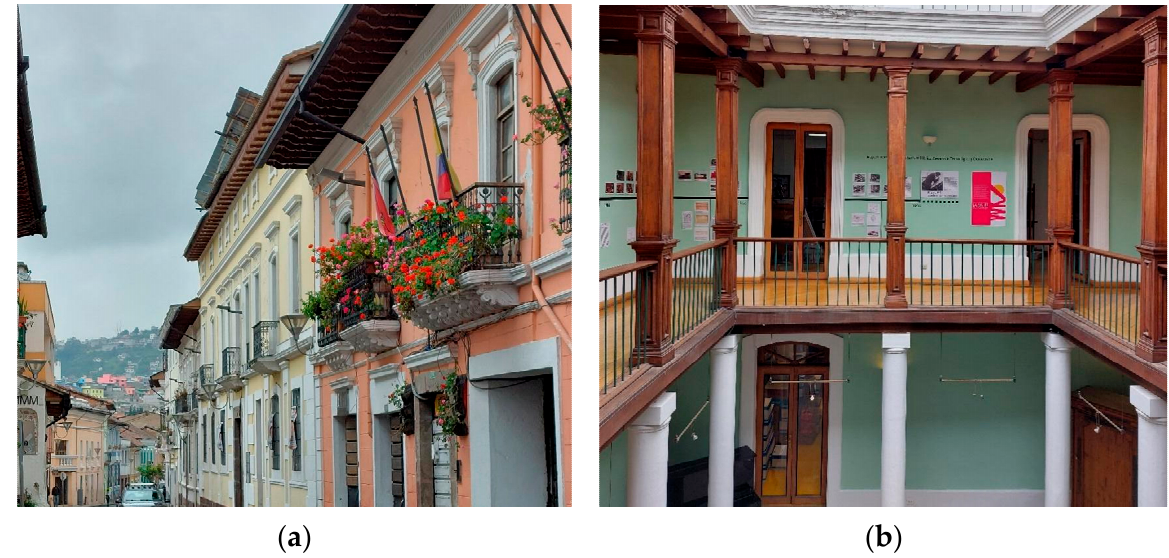
Figure 4. ( a ) View of traditional houses, Quito, 2022; ( b ) Hispanic patio of the Ecuadorian Museum of Architecture (MAE), Code: QU-8, Quito, 2022.